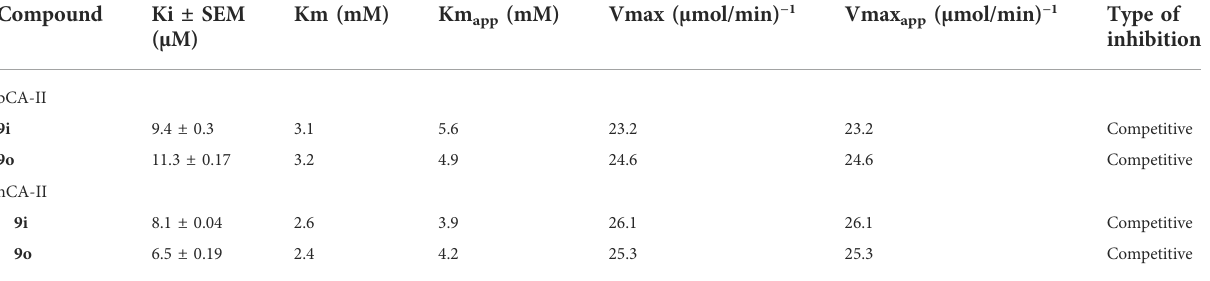
TABLE 3 Kinetic results of compounds 9i and 9o for enzymes bCA-II and hCA-II.